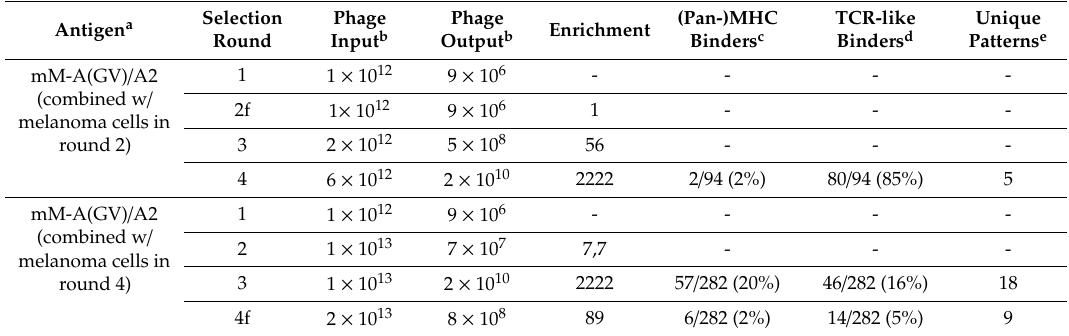
Table 1. Phage selections against wild type or heteroclitic mMA peptides complexed with